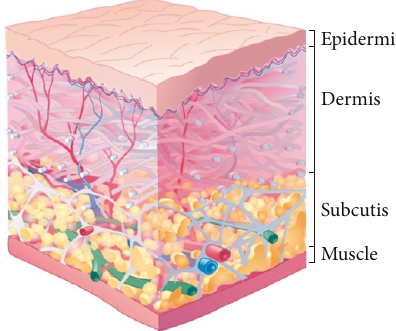
Figure 1: An overview of the layers of the skin and muscle. Upon injection into the subcutaneous compartment, insulin can either be absorbed by blood capillaries (red) and/or lymphatic capillaries (green). Adapted with permission from Taylor & Francis and Frost GI: Recombinant human hyaluronidase (rHuPH20): An enabling platform for subcutaneous drug and fl uid administration.